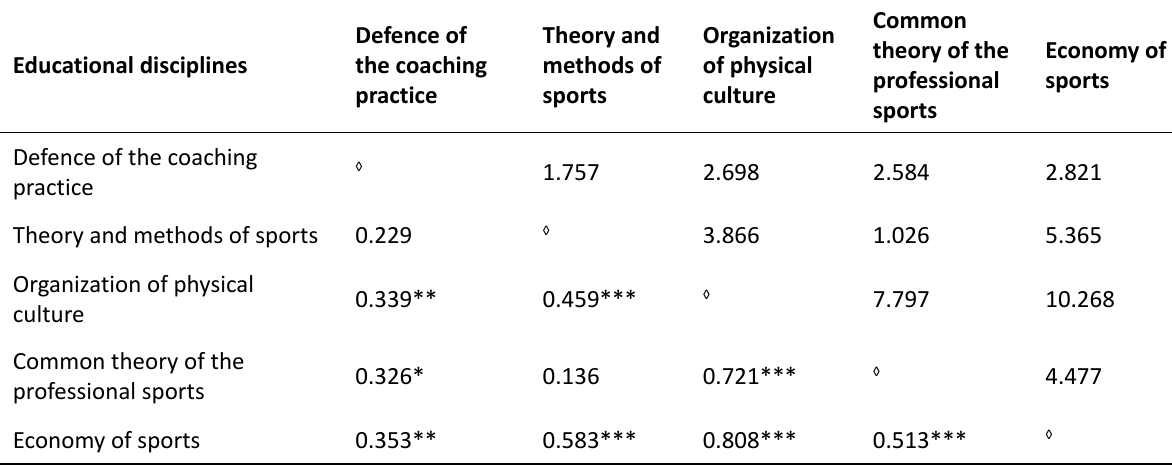
Table 6. Correlation table of the educational disciplines scores on the semester control of 4 th year: r-Pearson \ t-Student